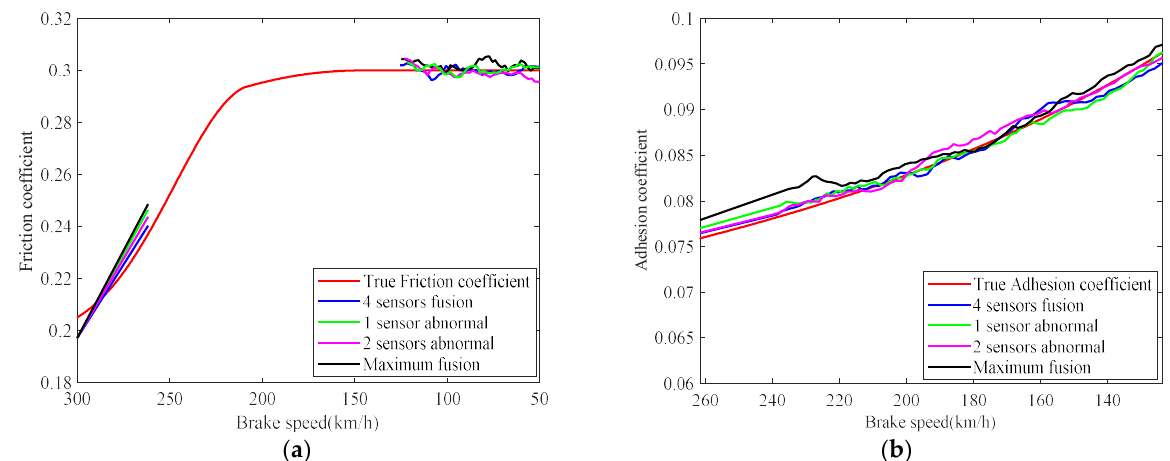
Figure 16. Identifications of friction coefficient and adhesion coefficient: ( a ) friction coefficient; ( b ) adhesion coefficient.